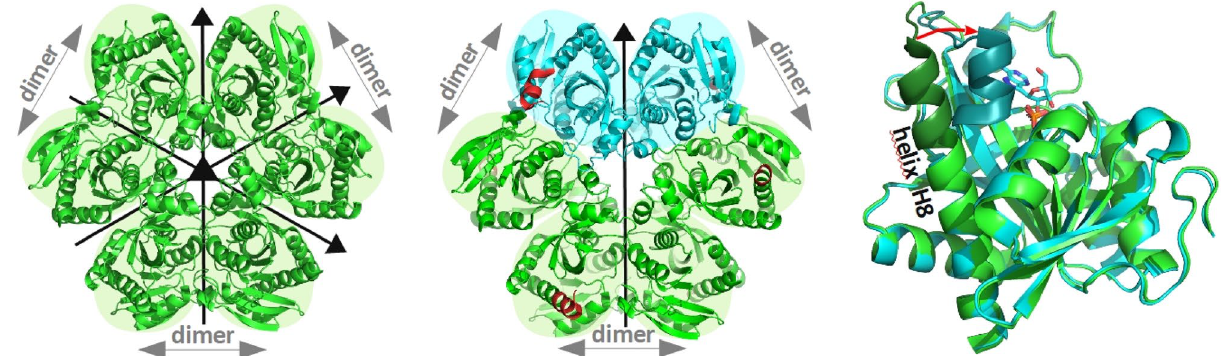
Figure 1. Left panel: Schematic view of the E. coli PNP in the apo form (PDB 1ECP 8 ). All dimers are symmetrical, as all subunits have the same, elongated structure of the helix H8, resulting in the open conformation of the active site. The overall structure of the enzyme may be therefore regarded as a trimer of dimers as well as a dimer of trimers since the molecule has 32 point group symmetry. Middle panel: Schematic view of the E. coli PNP complexed with phosphate (PDB 4TS3 19 ). In two subunits (here shown in cyan) binding of phosphate leads to the segmentation of the H8 helix and the partial closing of the active site pocket. Two dimers become unsymmetrical (shown here with cyan and green subunits), as they differ in the conformation of the N-terminal part of the H8 helix (shown in red). The third dimer (with green subunits) has both active sites in the open conformation, hence is symmetrical. The overall structure of the enzyme in this case is therefore a dimer of trimers. This kind of architecture is observed in the most of the crystal structures of E. coli PNP complexes available up to now, binary (with phosphate) and ternary (with phosphate and various nucleosides or purine bases). Right panel: Subunits in the open and closed conformation of the active site from the structure depicted in the middle panel, were overlaid to show differences in these two active site conformations: the segmentation of the helix H8 and the movement of its N-terminal part (shown in darker shades of green and cyan, respectively) and the loop towards the active site pocket (indicated by the red arrow).